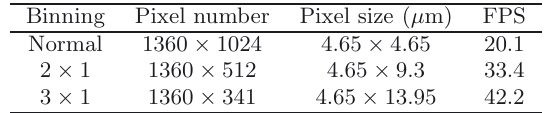
Fig. 1. Schematic representation of the 3 × 1 vertical pixel binning. Table 1. Some parameters of the CCD camera in used PB experiments (FPS-frame per second).